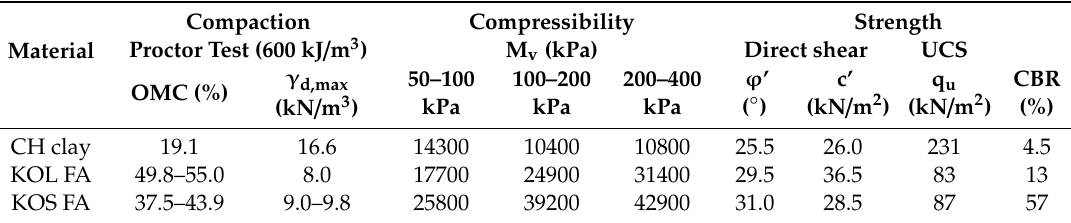
Figure 2. Flowchart of the laboratory testing program—ash and ash-slag mixtures. Table 5. Mechanical properties of tested materials without binders.